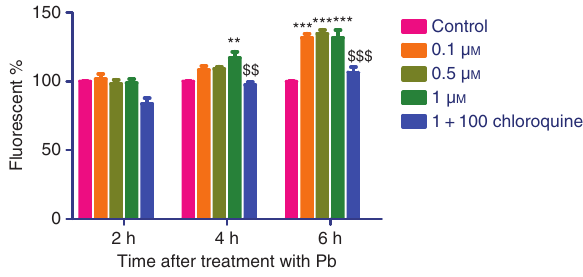
Figure 3: The effect of Pb on mitochondrial membrane potential. Collapse in mitochondrial membrane potential assayed using rho- damine 123 after 2 h, 4 h and 6 h treatment with Pb. Pb significantly